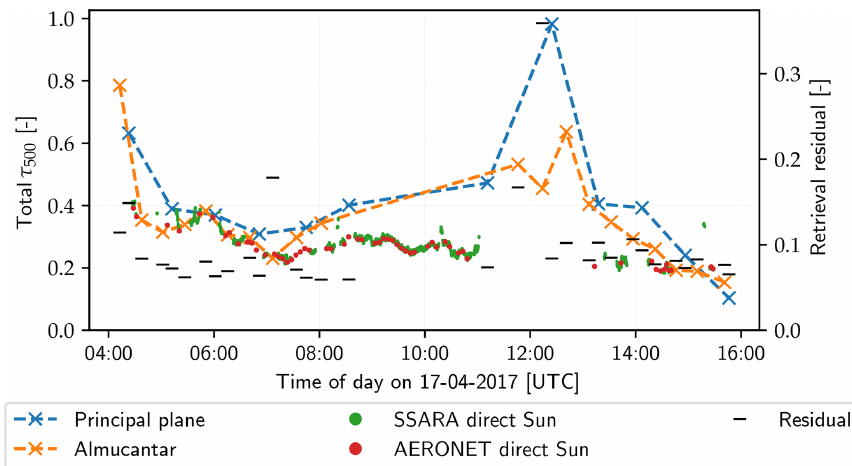
Figure 12. Total AOD at 500nm for 17 April 2017. Crosses indicate values retrieved from SSARA almucantar (orange) and principal plane (blue) scans. Green and red dots are from direct Sun observations with SSARA and AERONET, respectively. Note the agreement of these observations between the two instruments. The thin black markers represent the residual of the retrieved